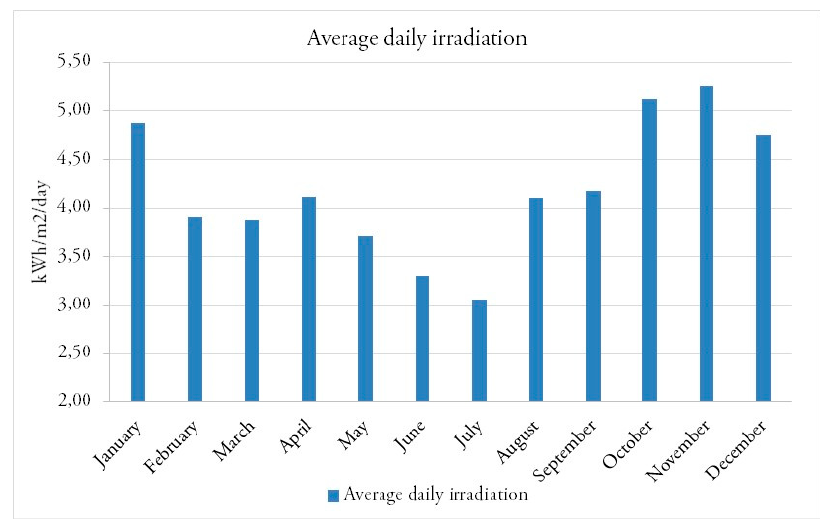
Figure 2. The average daily irradiation. Source: Based on NREL [37].